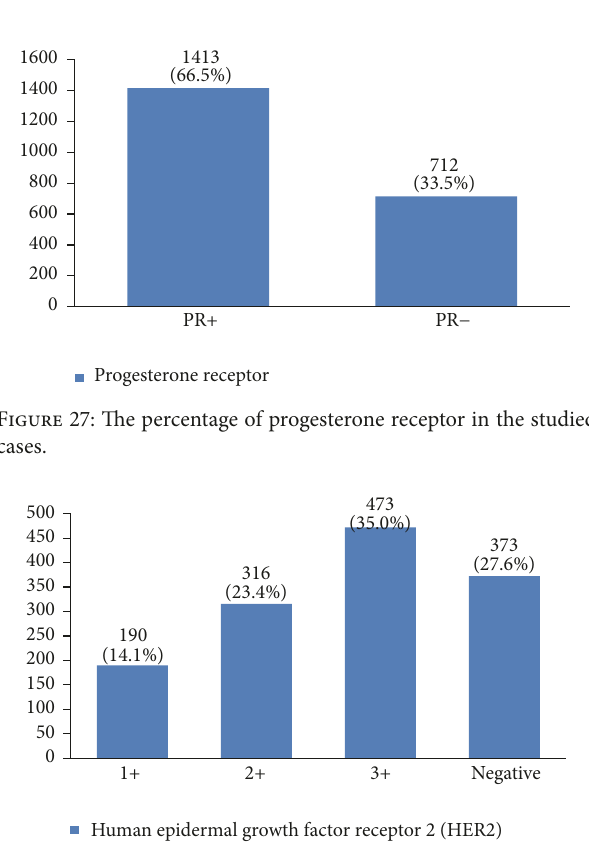
Figure 28: The distribution of HER2 types in the studied cases.